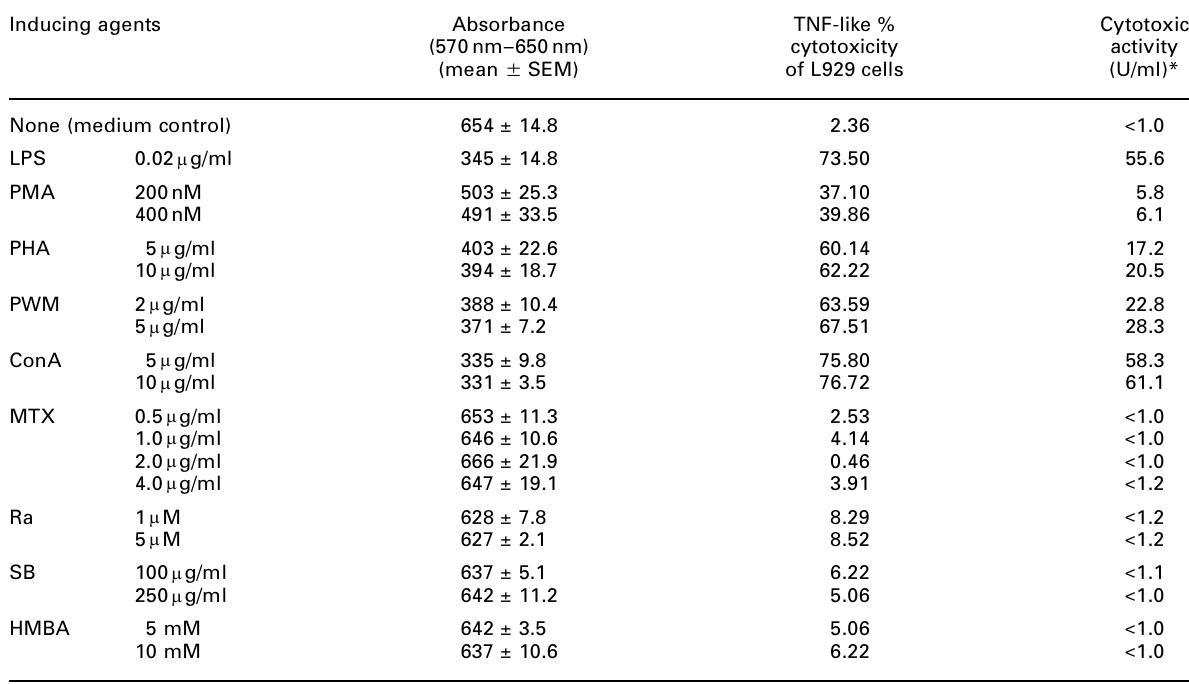
Table 1. TNF-like cytotoxicity in AMC supernatants stimulated by various agents Inducing